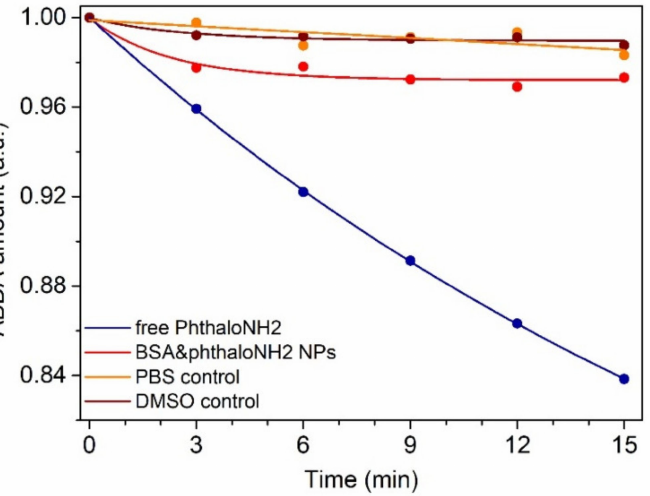
Figure 7. Degradation of ABDA molecule in the presence of free phthaloNH 2 (blue), BSA&phthaloNH 2 NPs (red), control PBS (orange), and DMSO (brown) solutions, monitored by modifications in the absorbance spectra of ABDA as a function of irradiation